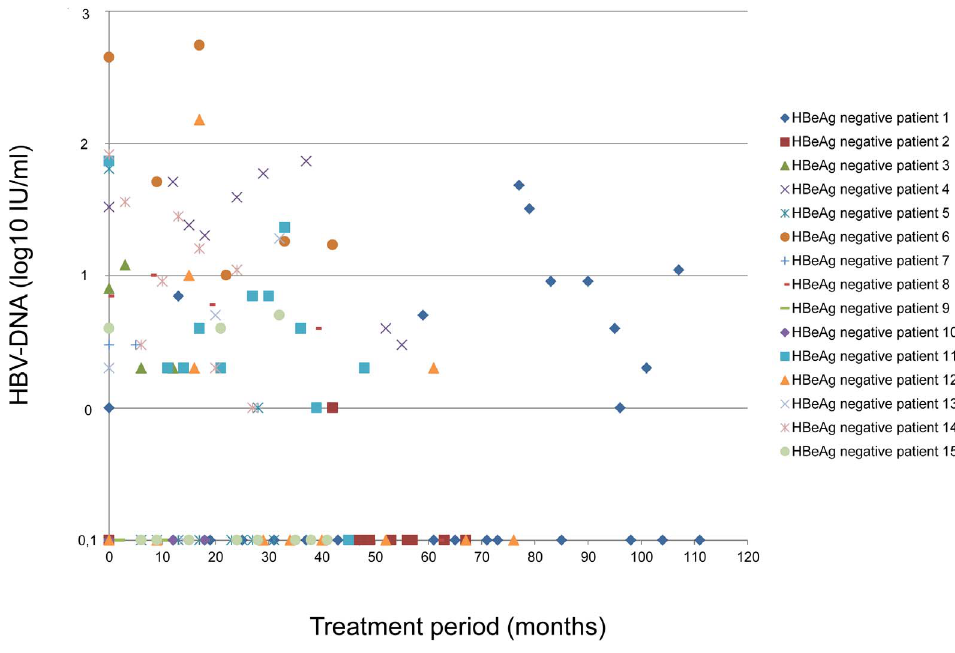
Figure 2. Minimal residual viremia in HBeAg positive individuals treated with nucleos(t)ide analogues.